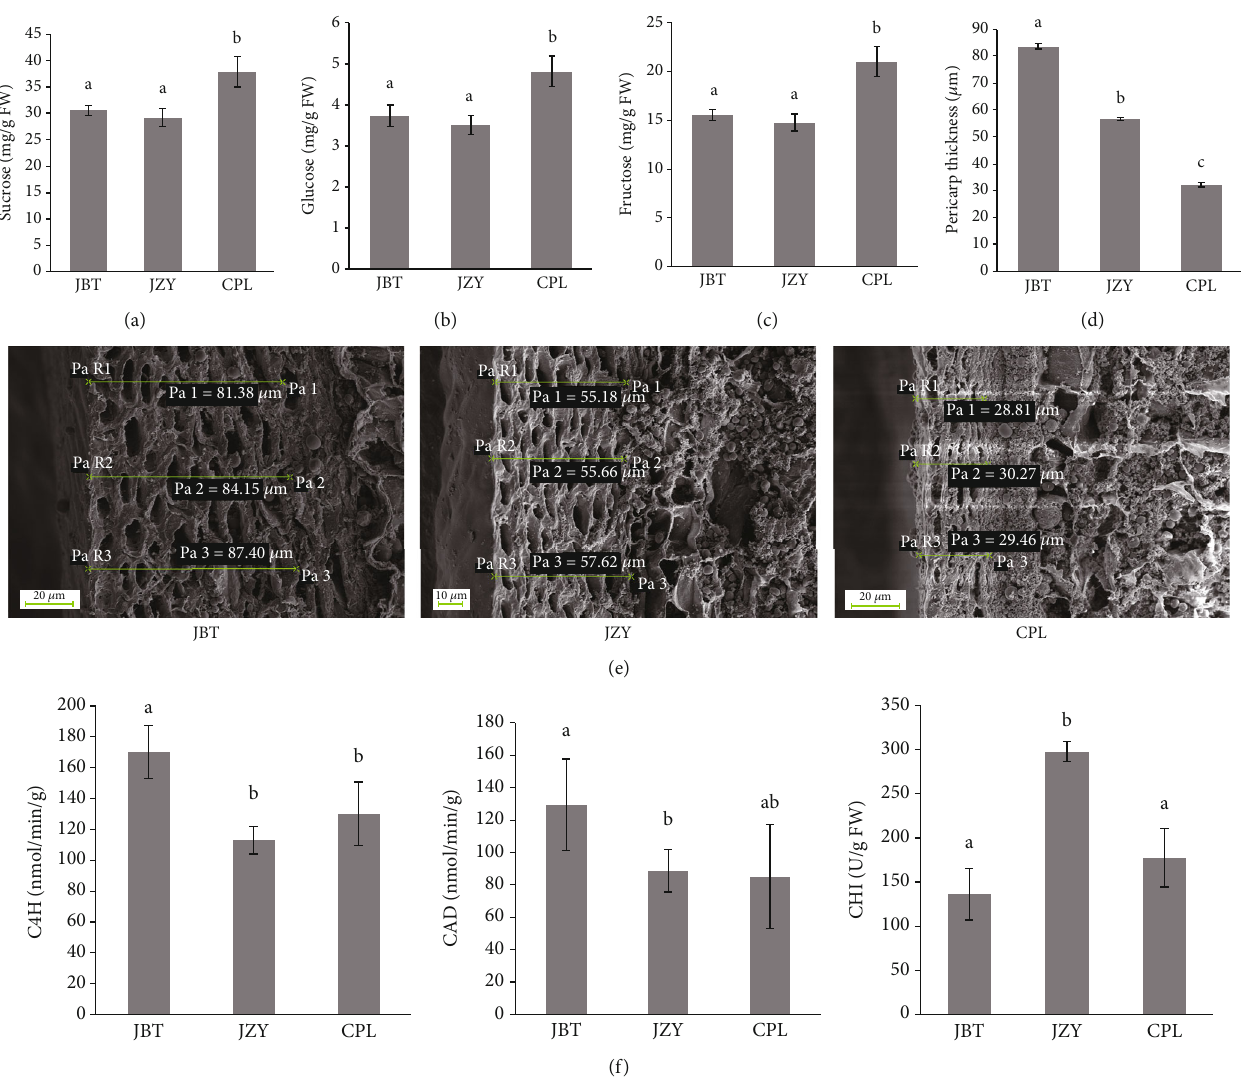
Figure 1: The sugar content and pericarp thickness in three sweet corn cultivars: (a) sucrose content; (b) glucose content; (c) fructose content; (d) pericarp thickness; (e) images of kernel pericarp in sweet corn using a scanning electron microscope. The results were shown as mean ± standard deviation with triplicate experiments for each sample ( P < 0 : 05 ); (f) enzyme activity of C4H, CAD, and CHI in three sweet corn